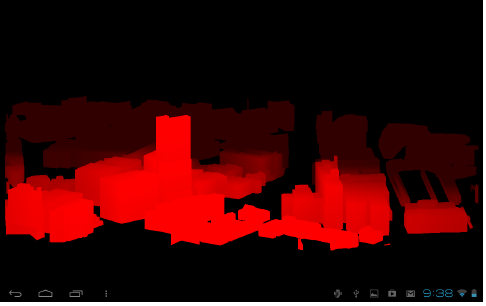
Figure 11: Sheffield - LoD 1/2 Dataset - City View